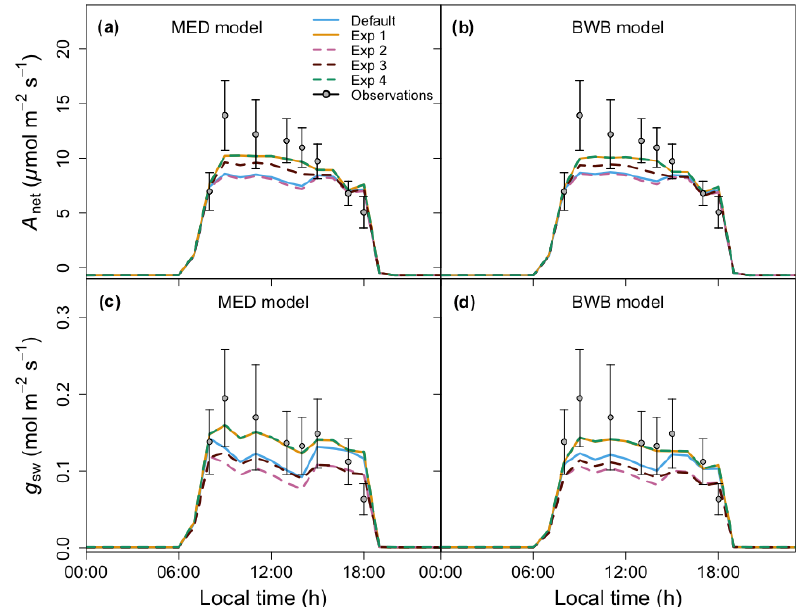
Figure 7. Comparison between the model outputs and measurements on 21 April 2016 for (a) the MED model net photosynthesis ( A net ), (b) the BWB model A net , (c) the MED model stomatal conductance ( g sw ), and (d) the BWB model g sw with different soil water stress effects on parameters in FATES (Table